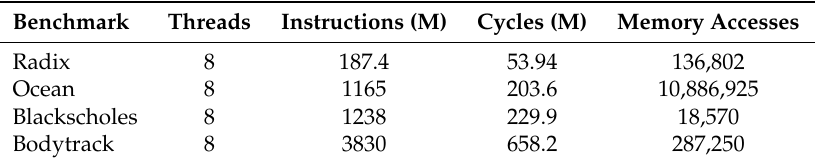
Table 3. Applications